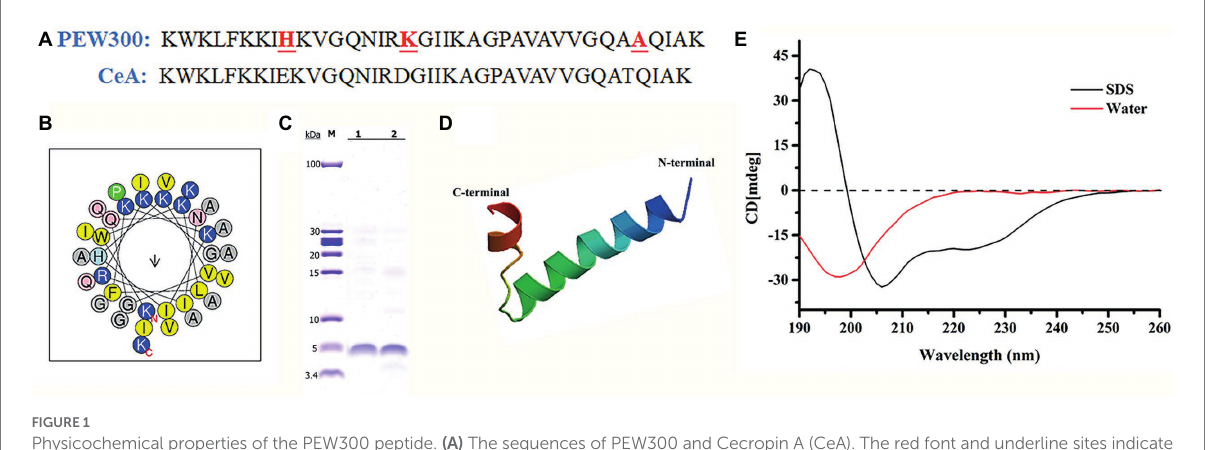
FIGURE 1 Physicochemical properties of the PEW300 peptide. (A) The sequences of PEW300 and Cecropin A (CeA). The red font and underline sites indicate mutation sites of the PEW300 peptide. (B) Predicted alpha-helical wheel of PEW300 peptide (https://heliquest.ipmc.cnrs.fr/cgi-bin/ ComputParams.py). The hydrophobic residues are yellow, positively charged hydrophilic residues are blue, and non-charged polar residues are gray. (C) Purification of PEW300 peptide. Line 1 and line 2 are purified PEW300 peptides. (D) The secondary structure of PEW300 predicted by SWISS-MODEL (https://swissmodel.expasy.org/interactive). (E) CD spectra of the PEW300